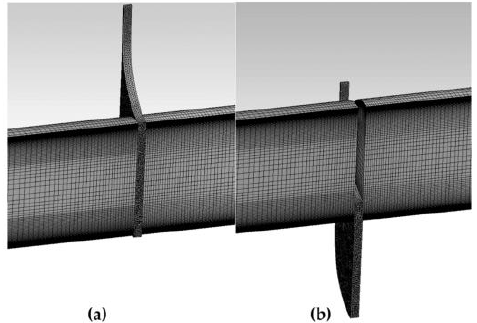
Figure 5. Sliding mesh method grid cut in half: ( a ) at t = 0 s before valve movement; ( b ) at t = 4 s close to the end of valve closure.